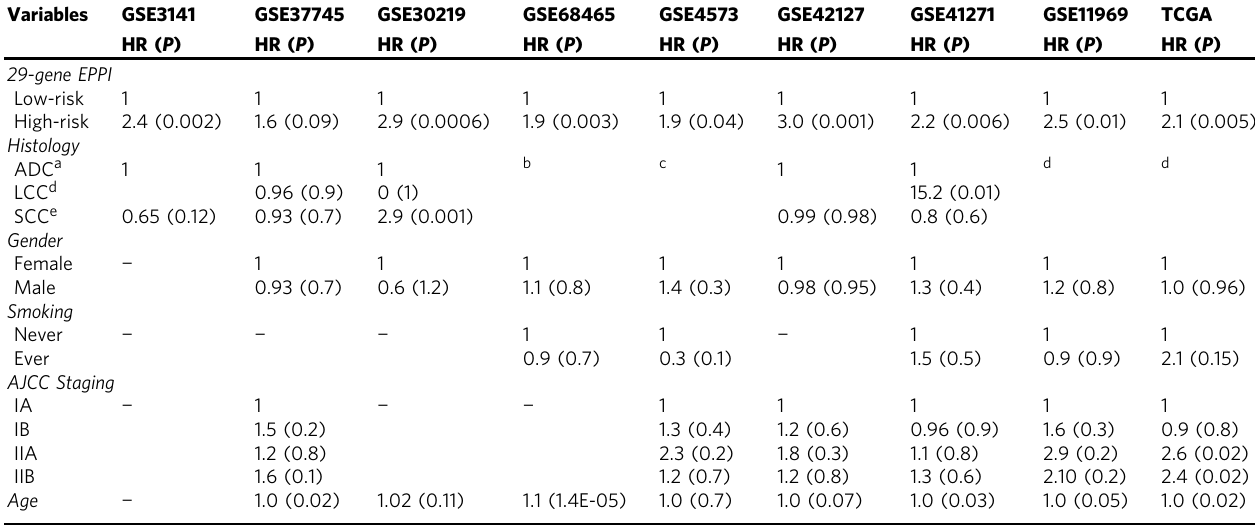
Table 1 The EPPI signature is an independent predictor of survival outcome in early-stage NSCLC